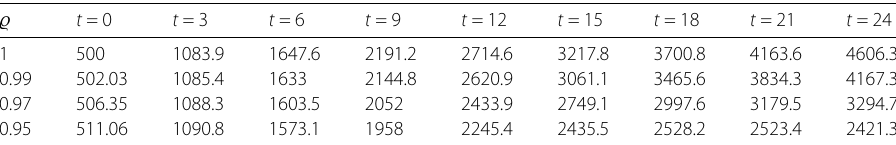
Table 4 Values of V ( t ) for four different orders of CF D (cid:2)